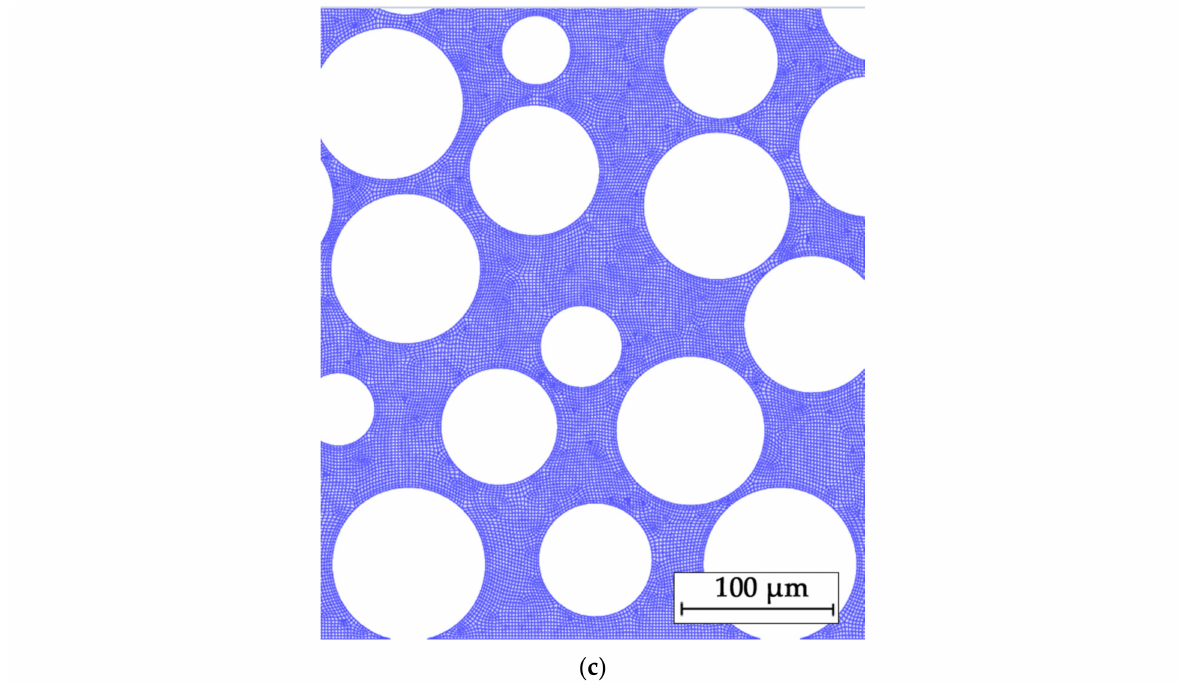
Figure 3. Computational grids: ( a ) 320,000 cells; ( b ) 786,000 cells; ( c ) 1,428,000 cells. Table 1. The results of test computations. Detailing the Computational Grid,